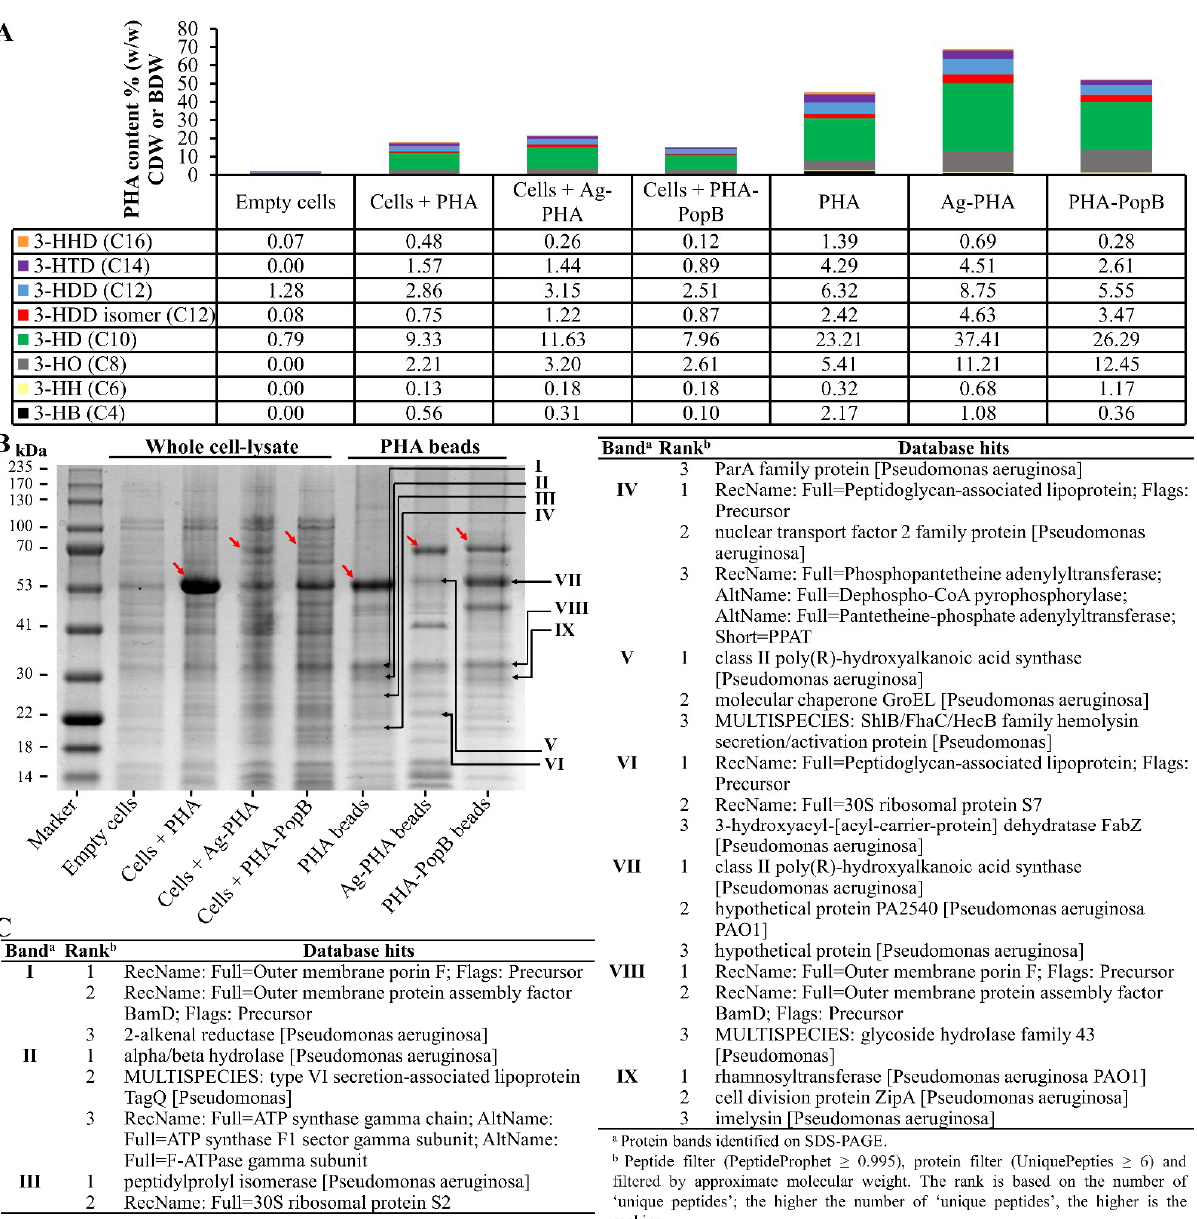
Figure 3. Composition of PHA bead vaccines isolated from engineered P. aeruginosa . ( A ) GC-MS for quantification and compositional analysis of PHA beads shown as percentage of CDW or BDW (CDW, cellular dry weight; BDW, bead dry weight). 3-HB (C4), 3-hydroxybutanoate; 3-HH (C6), 3-hydroxyhexanoate; 3-HO (C8), 3-hydroxyoctanoate; 3-HD (C10), 3-hydroxydecanoate; 3-HDD isomer (C12), 3-hydroxydodecanoate isomer; 3-HDD (C12), 3-hydroxydodecanoate; 3-HTD (C14), 3-hydroxytetradecanoate; and 3-HHD (C16), 3-hydroxyhexadecanote. P. aeruginosa PAO1 ∆ C ∆ 8 ∆ F is the negative control empty cells. ( B ) Protein profile analysis of whole-cell lysate and the PHA beads separated by SDS-PAGE and gel stained with Coomassie Blue. PHA (63.2 kDa), Ag-PHA (77.7 kDa), and PHA-PopB (86.4 kDa) fusion proteins (in red arrows) along with the HCPs were isolated from P. aeruginosa PAO1 ∆ C ∆ 8 ∆ F strain containing the respective plasmids. Selected co-purifying HCPs were numbered I-IX. The PHA and PHA fusion proteins were confirmed by mass spectrometry (Table S4). ( C ) Table summarizing the identification of the nine PHA bead associated HCPs by MS. Complete list is shown in Table